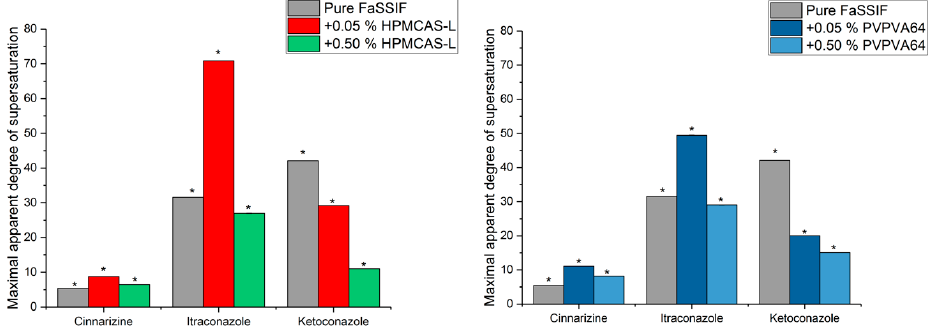
Figure 4. Maximum apparent degree of supersaturation of cinnarizine, ketoconazole and itraconazole in fasted state simulated intestinal fluid (FaSSIF) and in presence of hypromellose acetate succinate L-grade (HPMCAS-L) ( left ) and vinylpyrrolidine-vinyl acetate copolymer (PVPVA64) ( right ) using the solvent shift method SSPM [23]. Error bars are not visible in figure due to scaling.